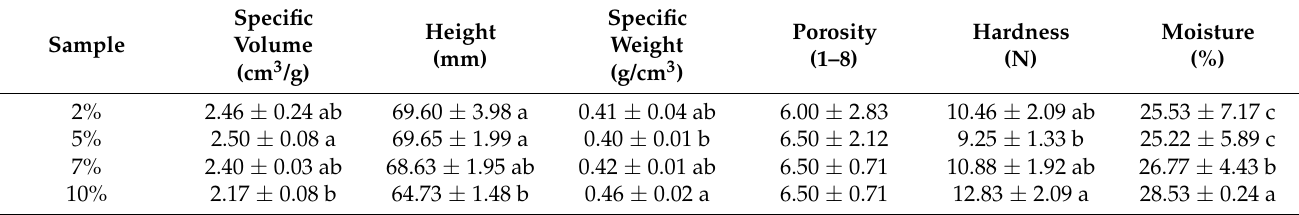
Table 9. Evaluation of physical properties of the bread samples produced using different levels of supplementation: two-factor ANOVA (analysis of variance) referred to the different percentages of integration of two flours (data are means ± standard